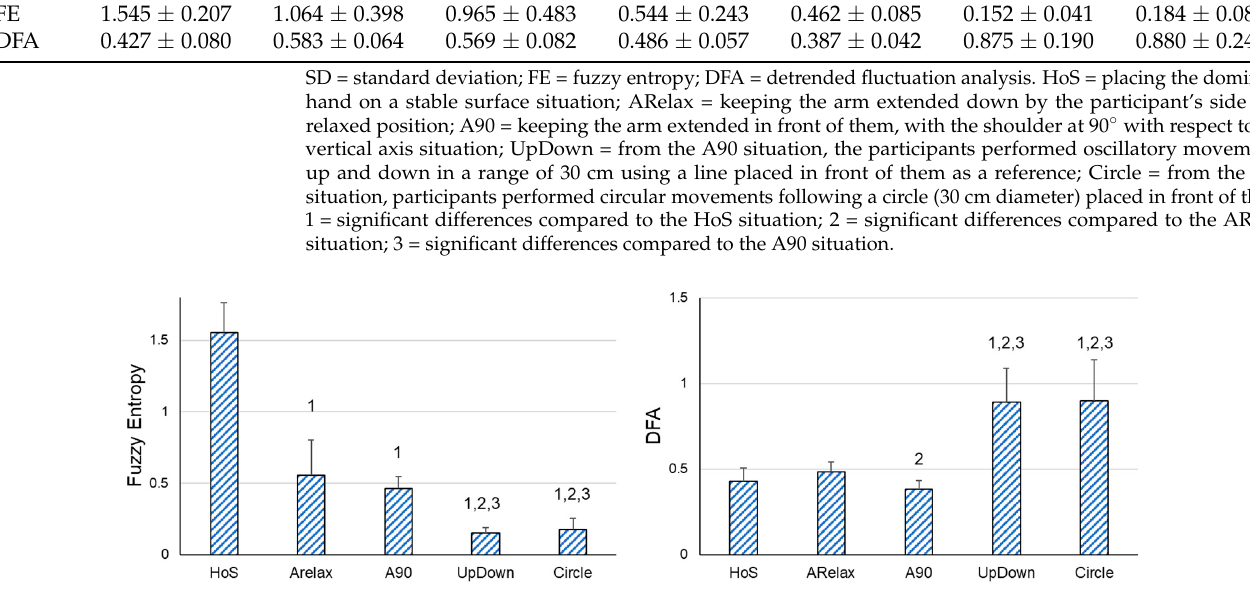
Analysis; HoS = placing the dominant hand on a stable surface situation; ARelax = keeping the arm extended down by the participant’s side in a relaxed position; A90 = keeping their arm extended in front of them, with the shoulder at 90° with respect to the vertical axis situation; UpDown = from the A90 situation, the participants performed oscillatory movements up and down in a range of 30 cm using a line placed in front of them as a reference; Circle = from the A90 situation, participants performed circular movements following a circle (30 cm diameter) placed in front of them. 1 = significant differences compared to the HoS situation; 2 = significant differences compared to the ARelax situation; 3 = significant differences compared to the A90 situation.